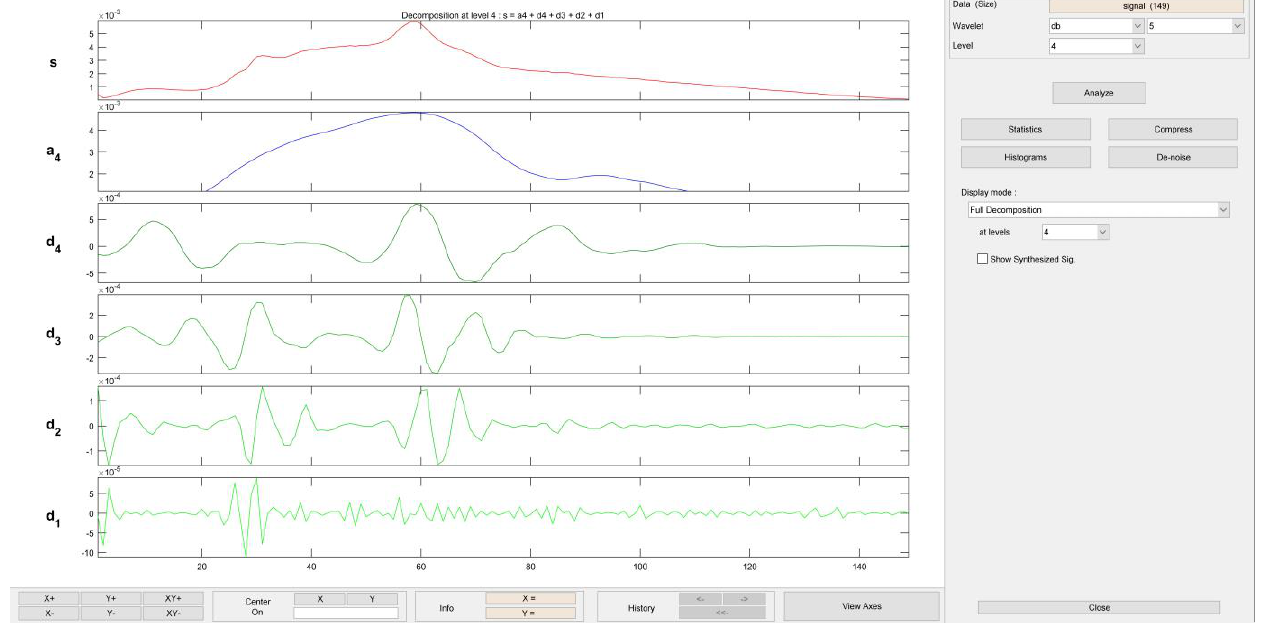
Figure 7. Wavelet transform signal decomposition into approximation and details.